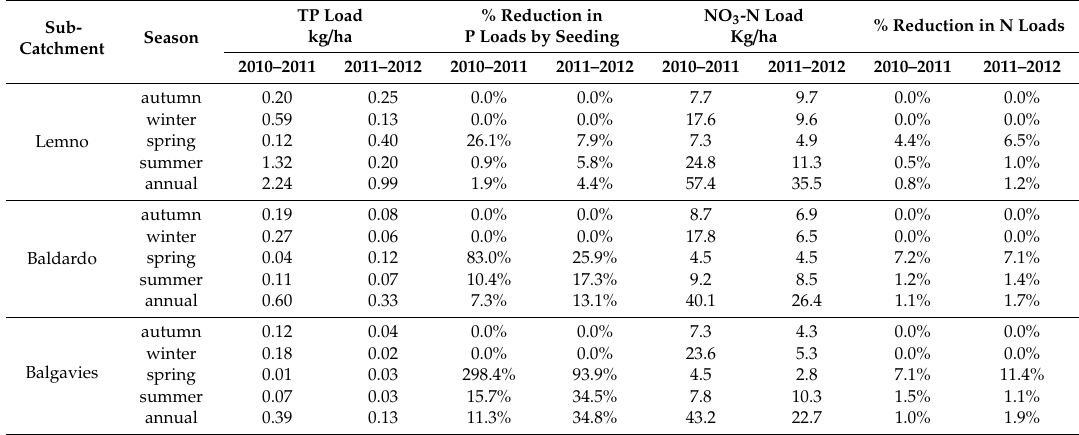
Table 4. Estimated impact of watercress seeding on P and N loads in upper Lunan Water sub-catchments. Sub-